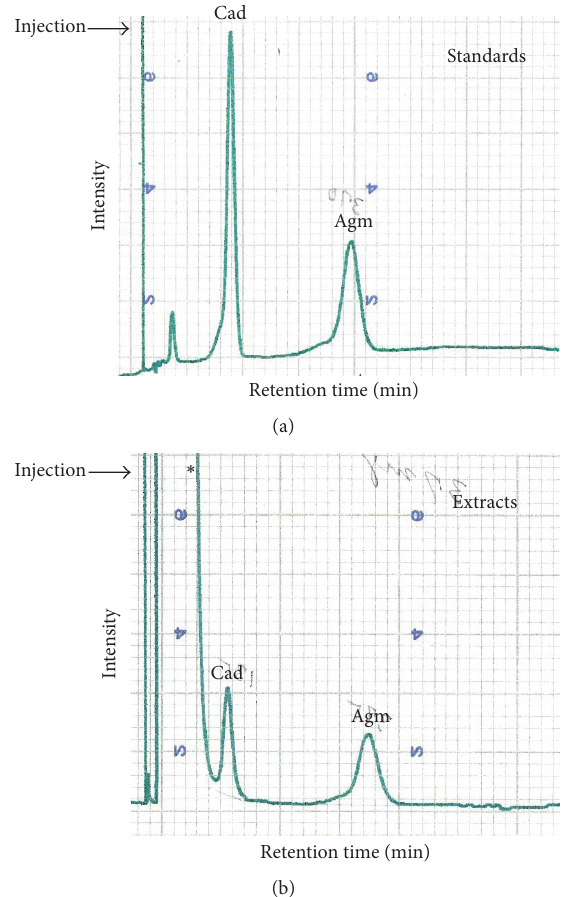
Figure 4: Intracellular polyamines analyses in Hfx. volcanii H26. H26 was grown at 42 ∘ C in Hv min medium. Intracellular polyamines from Hfx. volcanii H26 were extracted after 20 hours of growth. (a), peak standards; (b), samples after 20 hours of growth. Thirty-seven mg of extracts was injected. The ratio agma- tine/cadaverine is 6.96±3.28 . The injection is indicated by the arrow; ∗ unexpected noise derived from buffer.